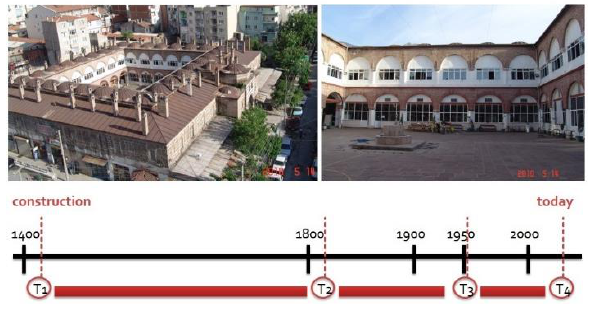
Figure 2. Kurşunlu Khan in Manisa, Turkey.